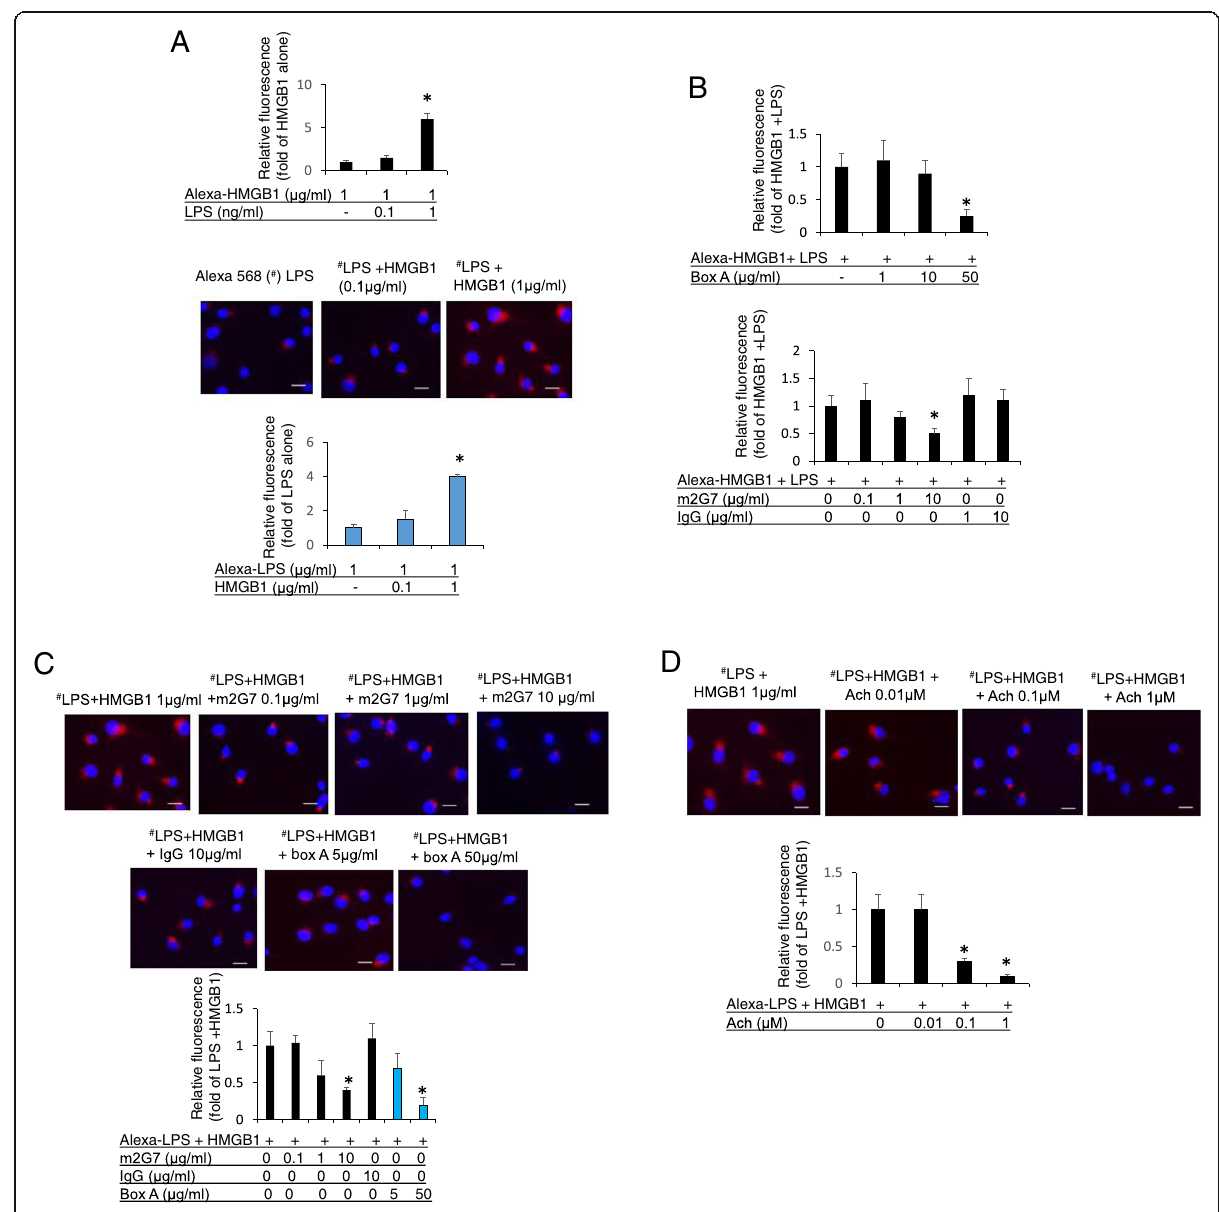
Fig. 6 Macrophage endocytosis of LPS-HMGB1 complexes was inhibited by m2G7, box A and acetylcholine. a . Upper: RAW 264.7 cells, seeded on 24- well culture plate on cover slips (1×10 4 /well), were incubated with Alexa 555 labeled HMGB1 (1 μ g/ml) alone or in combination with increasing amounts of LPS as indicated for 2h at 37°C. Endocytic results were expressed as fold change of Alexa 555-HMGB1 alone. N =30 – 35 cells per treatment and are representative from 6 independent experiments. Middle and lower: RAW 264.7 cells, seeded on 24-well culture plate on cover slips (1×10 4 /well), were incubated with Alexa 568 labeled LPS ( # red, 1 μ g/ml) in complex with HMGB1 as indicated. N =28 – 30 cells for each treatment. Endocytic uptake was expressed as fold change of Alexa 555-HMGB1 (upper) or Alexa 568-LPS (lower) alone. Scale bar=10 μ m. *: P <0.05 vs. Alexa 555-HMGB1 or Alexa 568-LPS alone. b . RAW 264.7 cells, on 24-well culture plate on cover slips (1×10 4 /well), were incubated with Alexa 555-HMGB1 (1 μ g/ml) in complex with LPS (1ng/ml), plus m2G7, mouse IgG or box A as indicated for 2h at 37°C. Endocytic uptake of Alexa 555-HMGB1 was expressed as fold change of Alexa 555-HMGB1+LPS. *: P <0.05 vs. Alexa 555-HMGB1+LPS. N=30 – 40 cells for each treatment. c . RAW 264.7 cells, on 24-well culture plate with cover slips (1×10 4 /well), were incubated with Alexa 568 labeled LPS ( # red, 1 μ g/ml) in complex with HMGB1 (1 μ g/ml), together with m2G7, mouse IgG or box A as indicated for 2h at 37°C. Endocytic uptake of Alexa 568 LPS was expressed as fold of Alexa 568-LPS+ HMGB1. Scale bar =10 μ m. *: P <0.05 vs. Alexa 568-LPS+HMGB1. N=30 – 35 cells for each treatment. d . RAW 264.7 cells, seeded on 24-well culture plate on cover slips (1×10 4 /well), were incubated with Alexa 568 labeled LPS ( # red, 1 μ g/ml) in complex with HMGB1 (1 μ g/ml), together with acetylcholine as indicated for 2h at 37°C. Endocytic uptake of Alexa 568 LPS was visualized, analyzed and quantified using Image J. *: P <0.05 vs. Alexa 568-LPS+HMGB1. N=30 – 35 cells for each treatment. Scale bar =10 μ